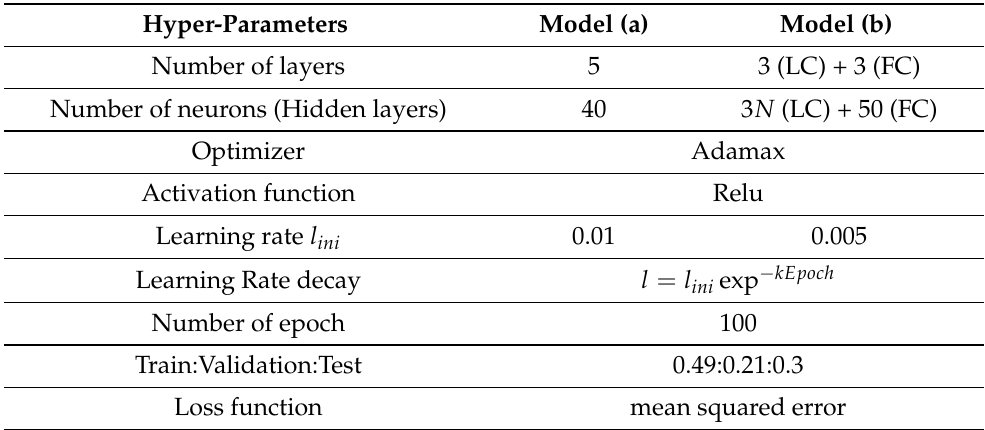
Table 2. Hyper-parameters of the proposed ANN model.